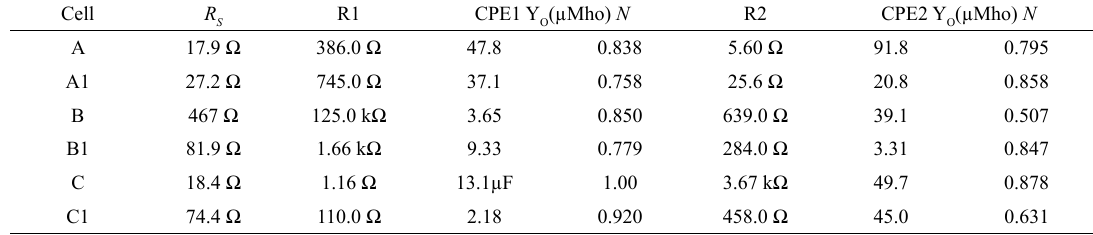
cells (A); TiO -450 °C (A1); NaTiNT (B); NaTiNT-450 °C (B1); Nanoribbons 2 2